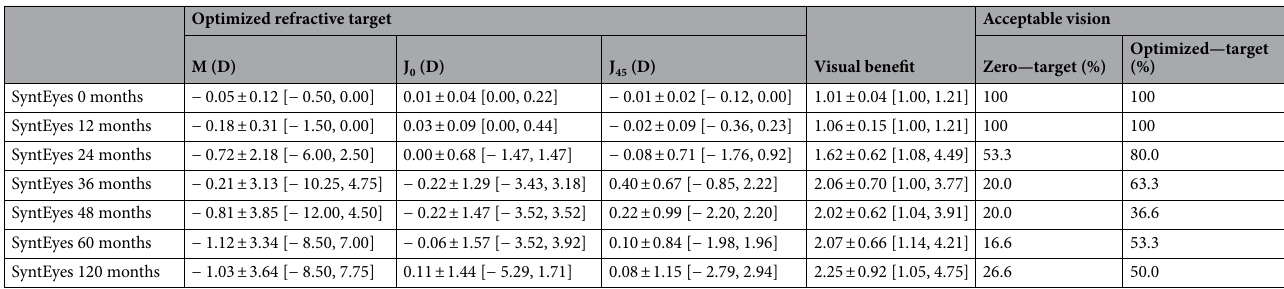
Table 2. Optimized refractive target, visual benefit and comparison between the zero-target and optimized methods (average ± standard deviation [minimum,